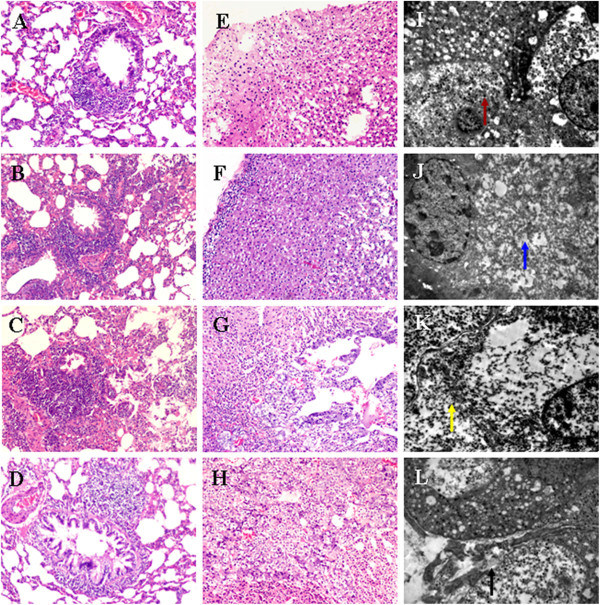
Pathological changes in lung and adrenal medulla tissues in offspring rats. Lung and adrenal medulla tissue sections (4 μm) from pups were stained with H&E, and the morphological changes were observed under a light microscope. Representative micrographs (100×) of lungs from OCP (A), OAP (B), ONP (C), and OANP rats (D). Representative micrographs (100×) of adrenal medulla in OCP (E), OAP (F), ONP (G), and OANP rats (H). Ultrathin sections (50 nm) from adrenal medullae were prepared from the different specimens and stained with uranyl acetate and lead citrate. Examinations of ultrastructural changes were carried out with an H-7500 TEM. Representative electron micrographs (10,000×) of adrenal medullae in OCP (I), OAP (J), ONP (K), and OANP rats (L). Colored arrows indicate chromaffin granules (red), swollen cytoplasm (blue), neurite-like processes (yellow), and deposition of collagen tissue (black).